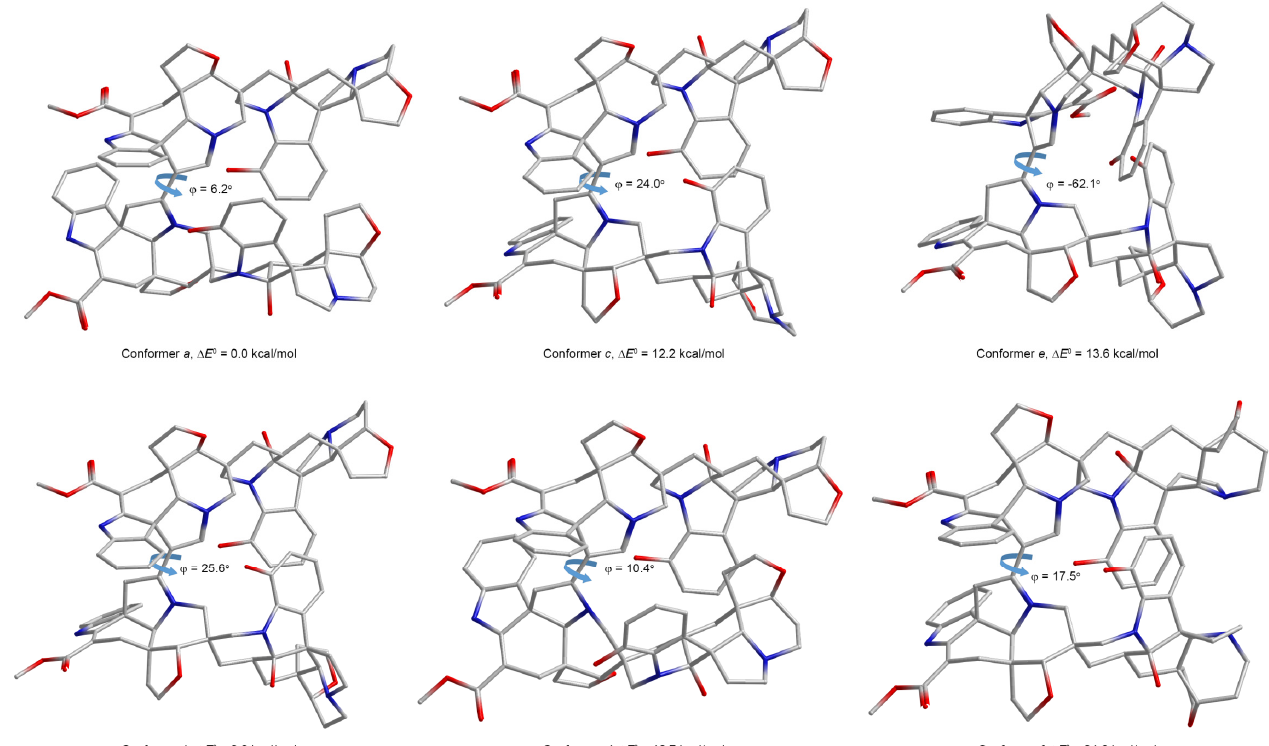
Figure 2. Three-dimensional structures of the conformers a – f of alasmontamine A, optimized at the M06-2X/aug-cc-pVTZ level. Indicated dihedral angles ϕ describe the internal rotation of two subunits around the C-5-C-6” bond. Adopted with minor editing privilege from the preliminary publication by Semenov and Krivdin [10].